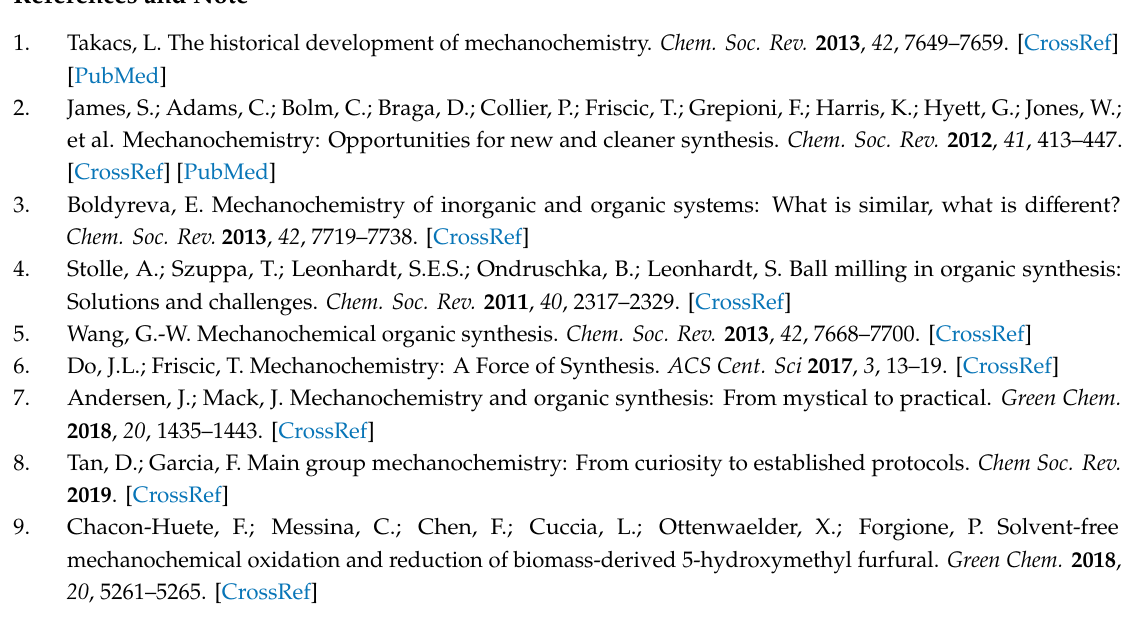
Figure S1: 1H NMR of substrates and calculation of